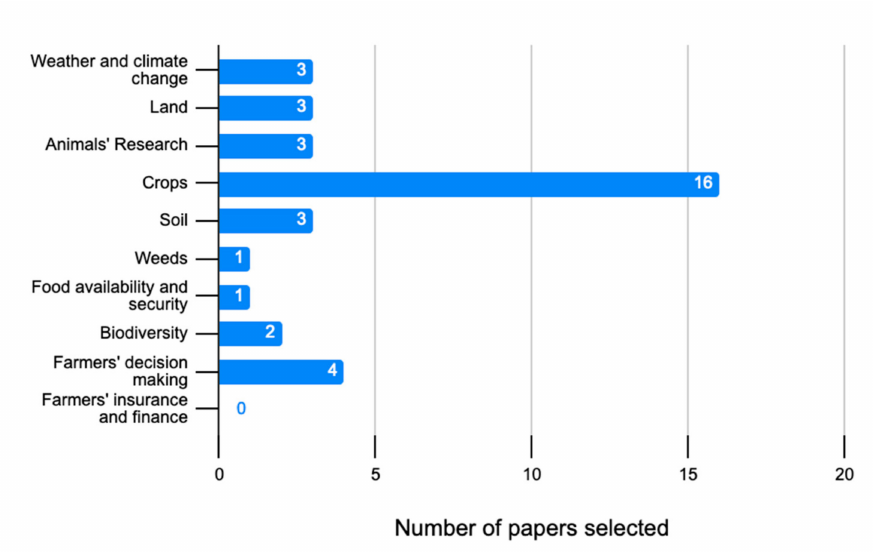
Figure 7. Distribution of papers selected by agriculture